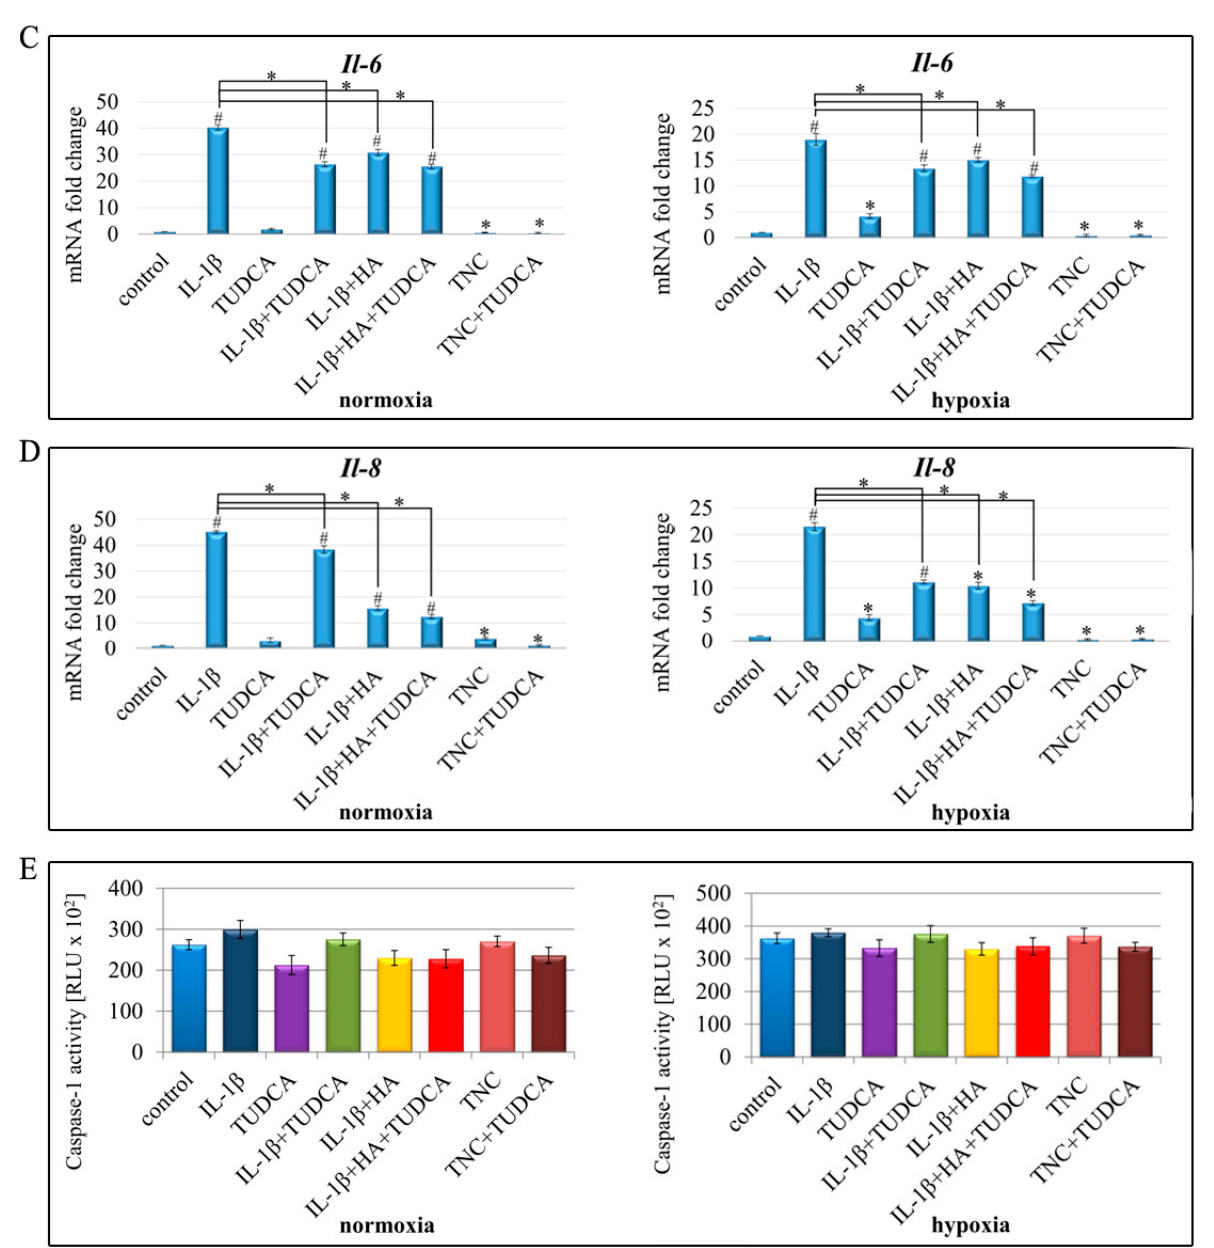
Figure 4. Inflammatory response in NHAC-kn chondrocyte cells stimulated with IL-1 β , TUDCA, IL-1 β +TUDCA, IL-1 β +HA, IL-1 β +HA+TUDCA, TNC, and TNC+TUDCA for 72 h. Relative quantification of Il-1 β ( A ), Cox2 ( B ), Il-6 ( C ), and Il-8 ( D ), expressions in normoxic and hypoxic conditions. Results of qRT-PCR are shown as relative fold change in mRNA expression in comparison to untreated controls, where expression level was set as 1. Caspase 1 activity in normoxia and hypoxia ( E ). Results presented as relative luminescence units and compared to untreated controls. Results of qPCR and luminescence-based analyses are presented as mean ± SD from three independent experiments run in triplicate. Significant changes are expressed relative to controls and marked with asterisks and hashes placed above the columns, or as specifically indicated with dashes linking compared treatments. Statistical significance was considered if * p < 0.05 or # p < 0.001.